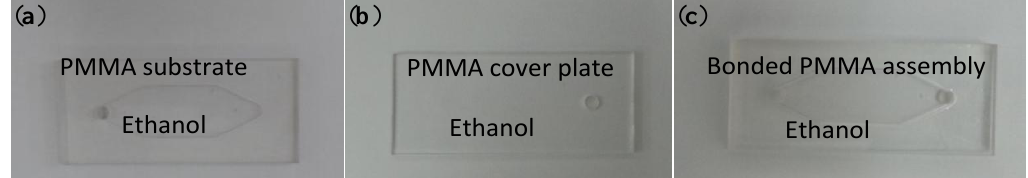
Figure 4. Overall procedure for the bonding of two polymethylmethacrylate (PMMA) substrates (70 mm × 20 mm) via ethanol treatment and then hot pressing. ( a ) The PMMA substrate in the ethanol treatment; ( b ) the PMMA cover plate in the ethanol treatment; ( c ) the bonded PMMA